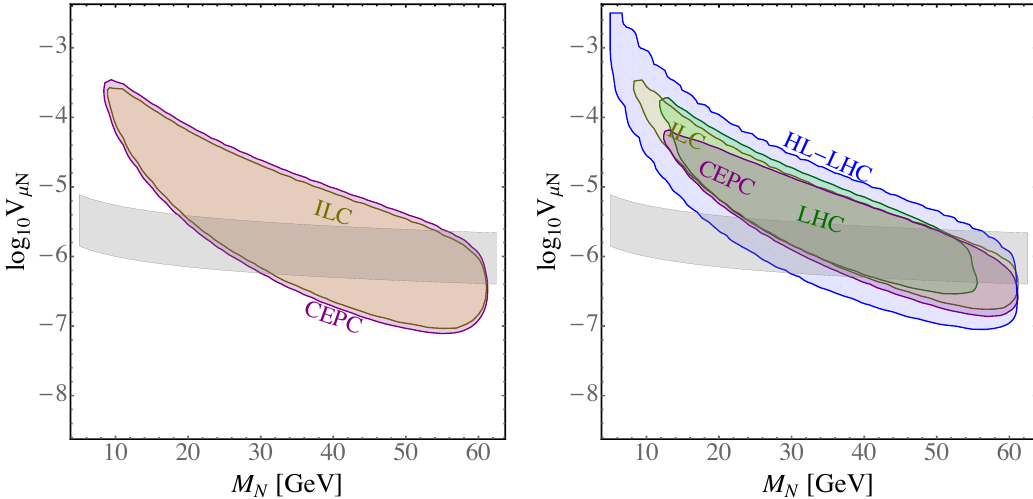
Figure 8 . Left: excluded regions in the ( M N ; V (cid:22)N ) parameter space at 95% C.L. assuming no observation of a single displaced vertex for the 5000 fb (cid:0) 1 ILC (red) and CEPC (blue).The grey band indicates the parameter region where a light neutrino mass in the interesting range is generated, 0 : 01 eV < m (cid:23) = V 2 m N < 0 : 3 eV. Right: excluded regions in the ( M N ; V (cid:22)N ) parameter space at (cid:22)N 95% C.L. assuming no observation of two displaced vertices for the 100 fb (cid:0) 1 LHC (green), 5000 fb (cid:0) 1 ILC (red) and CEPC (purple) and 3000 fb (cid:0) 1 HL-LHC (light blue).